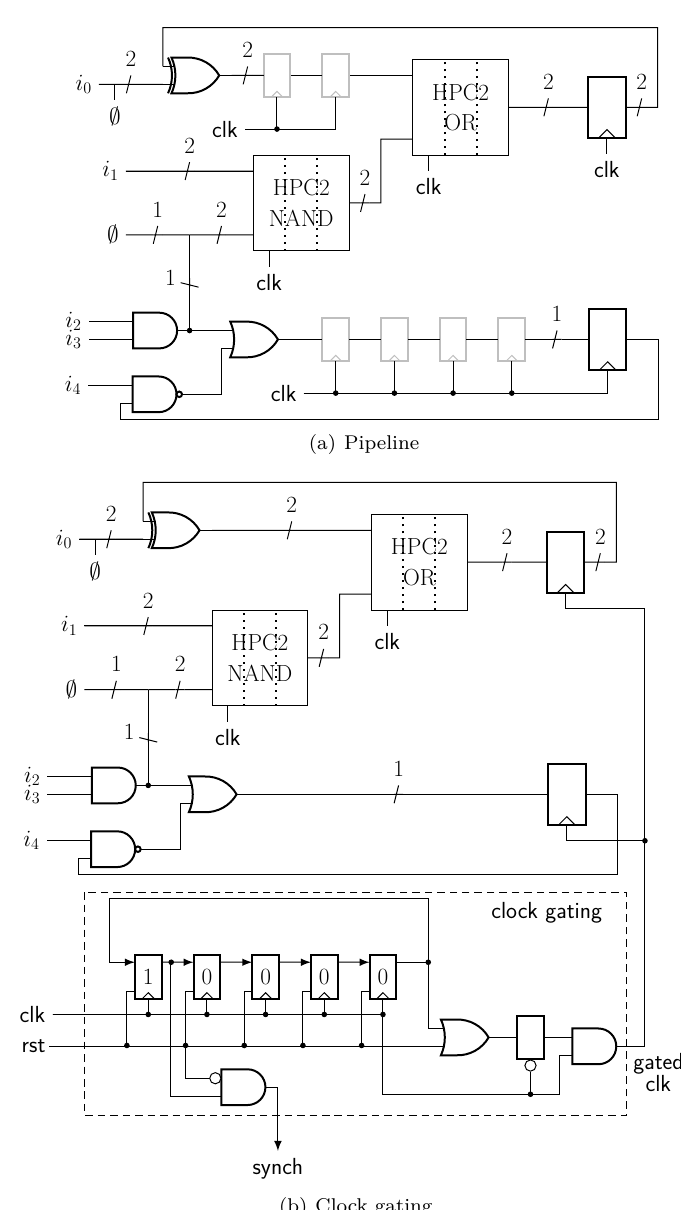
Figure 7: Different architectures: pipeline versus clock gating for the secure zone of the exemplary circuit in Figure 4 processed by the Naive method using HPC2 masking scheme.